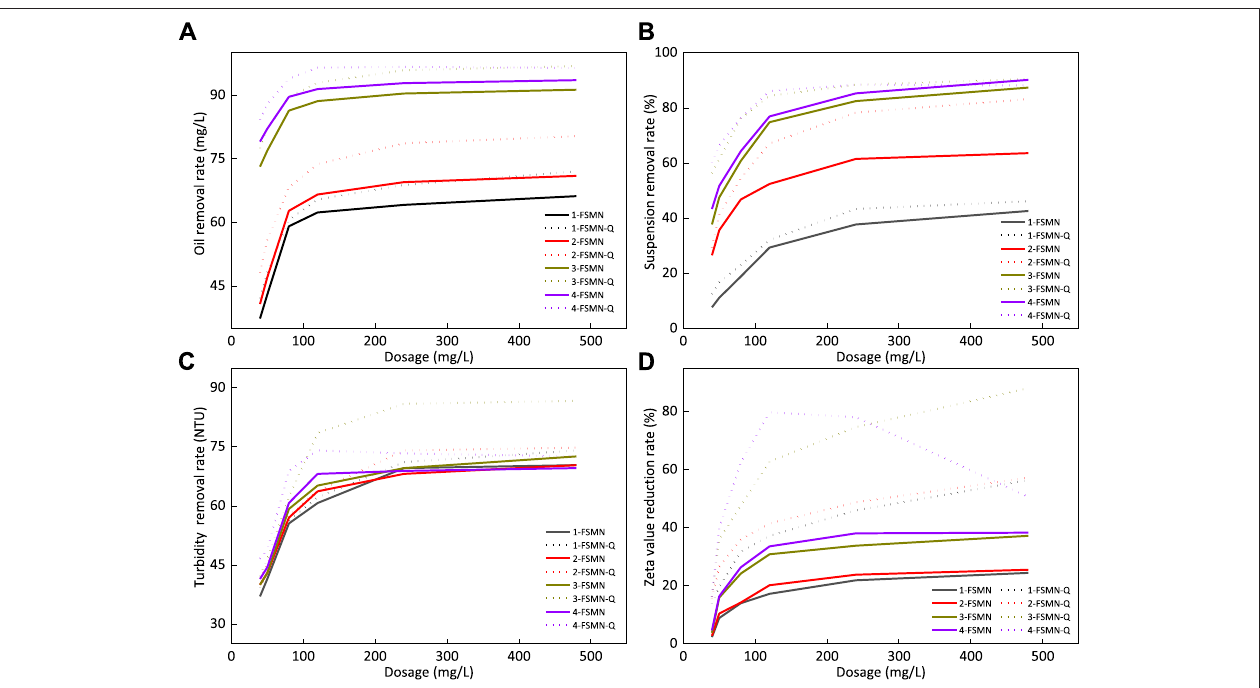
FIGURE 11 | Oil removal rate (A) , suspended solids removal rate (B) , turbidity removal rate (C) , and zeta potential reduction rate (D) of FSMN family and its quaternary ammonium salt.